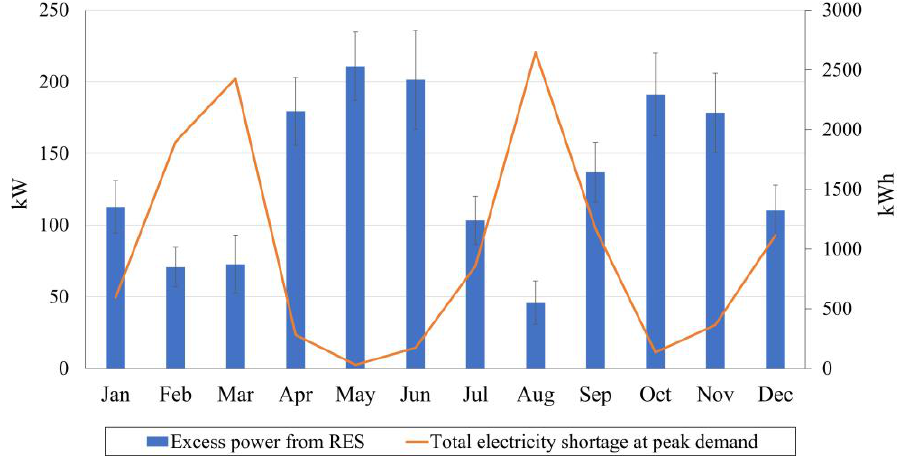
Figure 6. Simulated average excess RES power and total electricity shortage at peak demand from the operation of the suggested hybrid system.